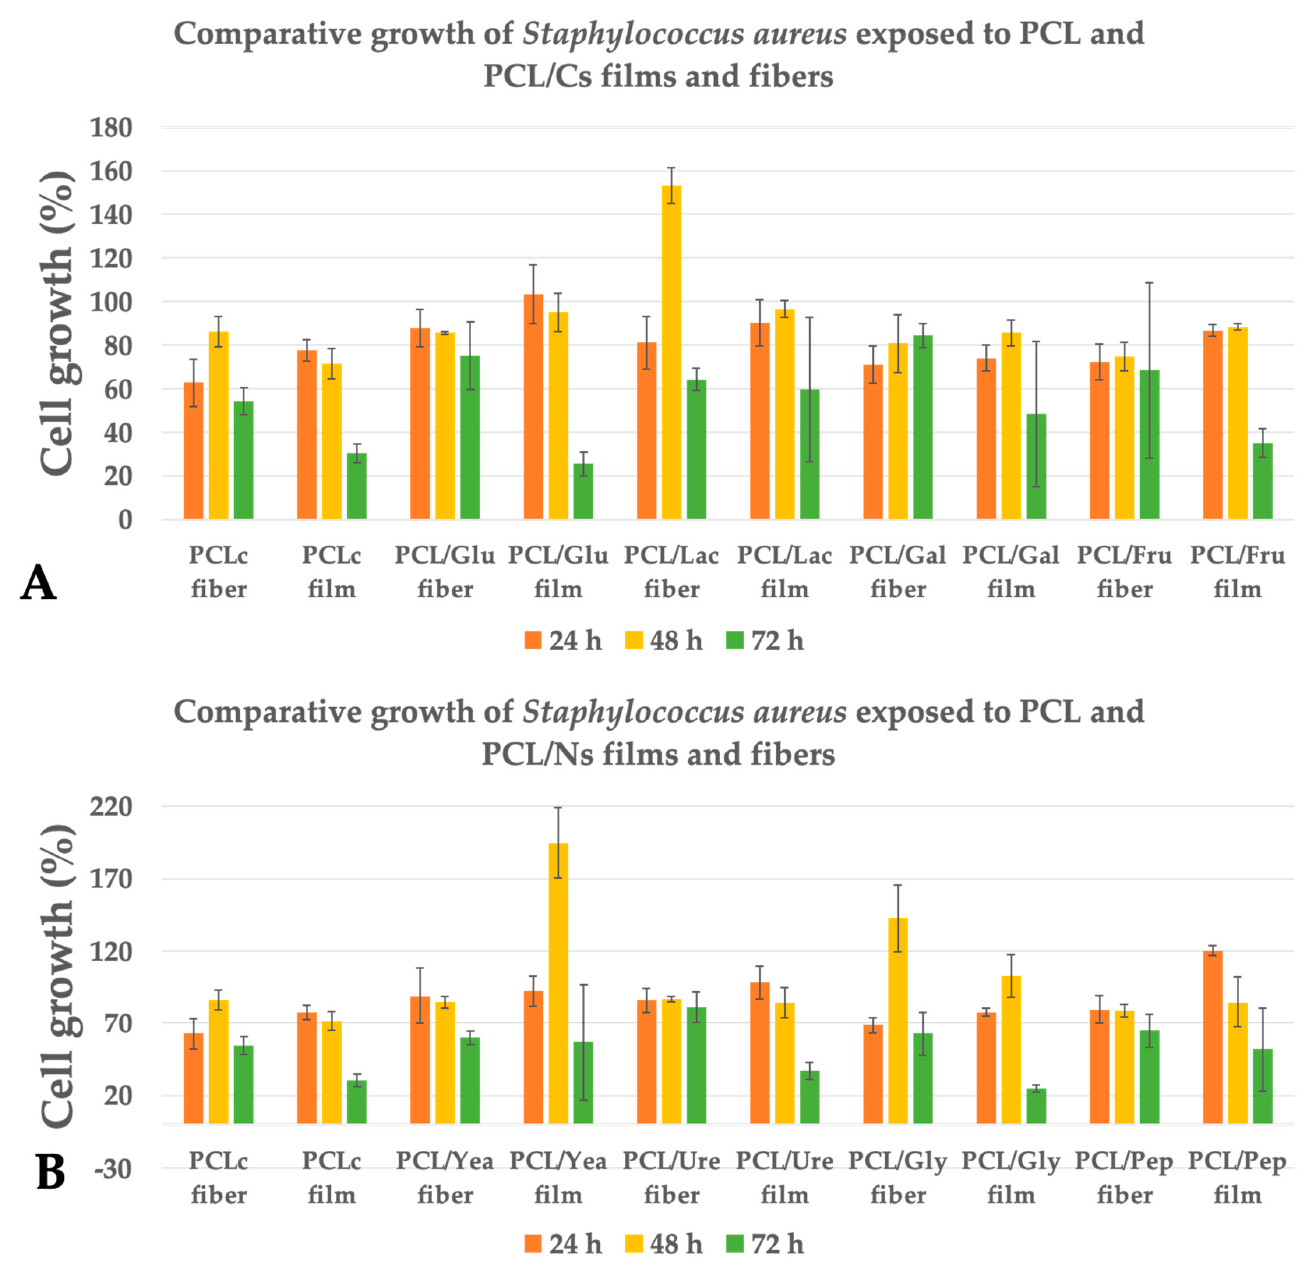
Figure 6. Comparative growth of Staphylococcus aureus exposed to ( A ) PCL/Cs and ( B ) PCL/Ns for fibers and films.